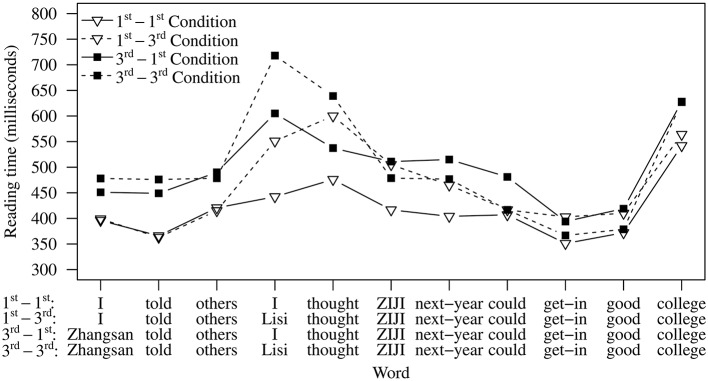
Average reading times per word in Experiment 1.